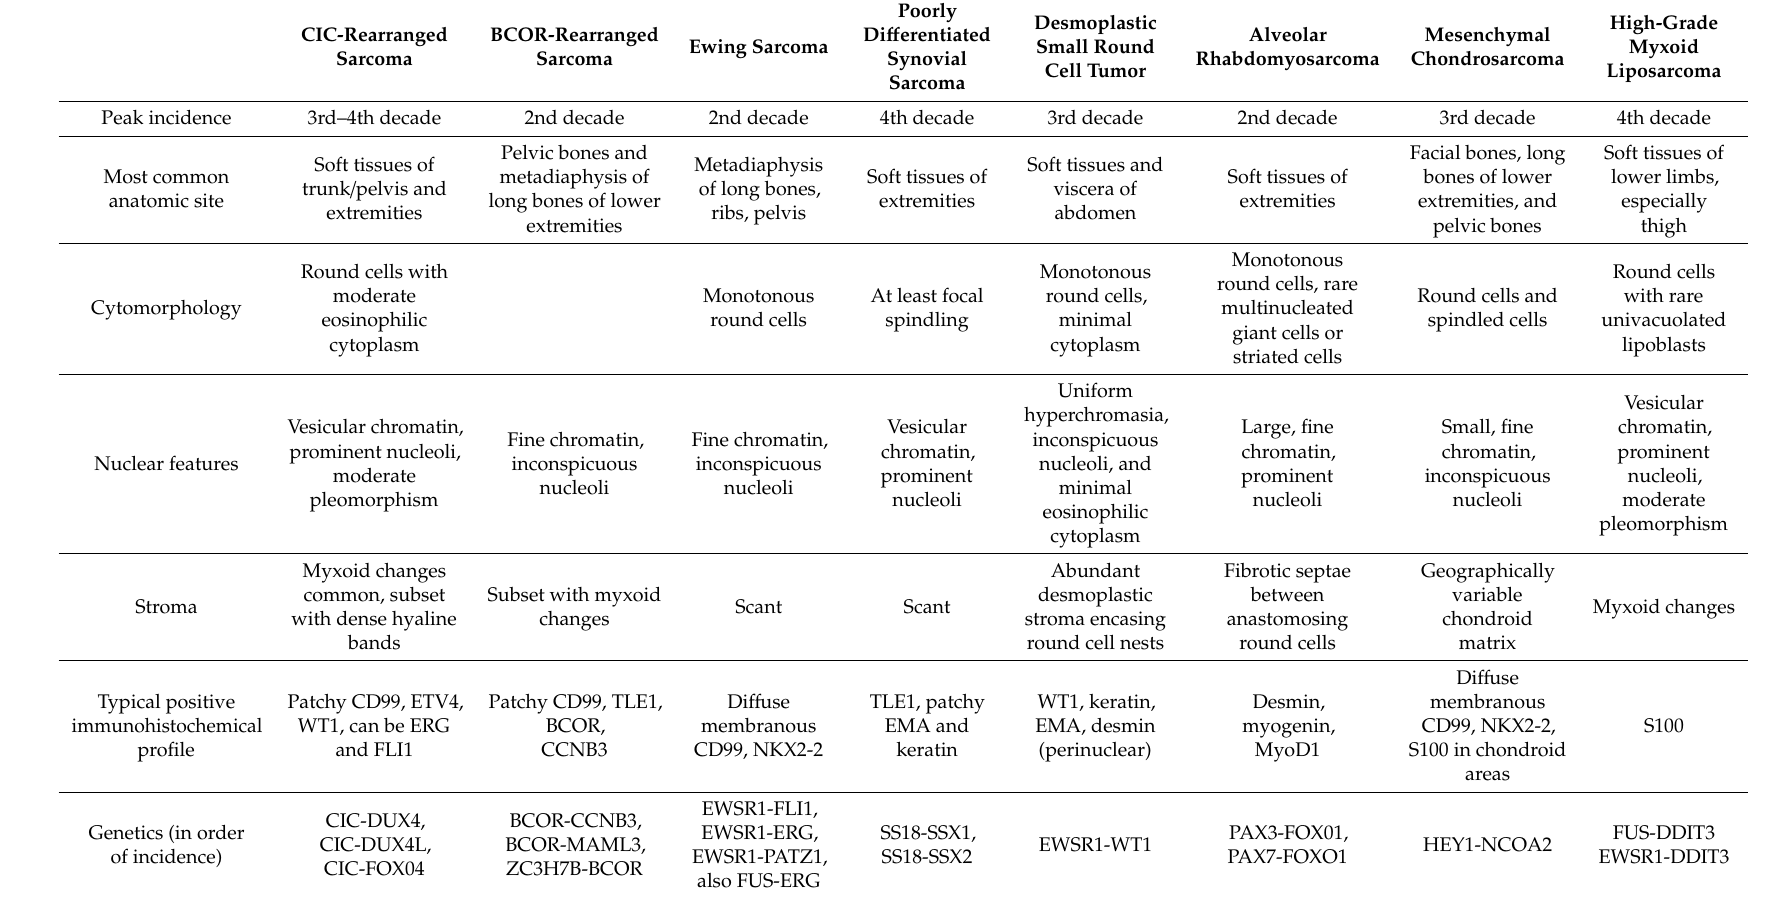
Table 1. Di ff erential diagnosis of round cell sarcomas (readapted